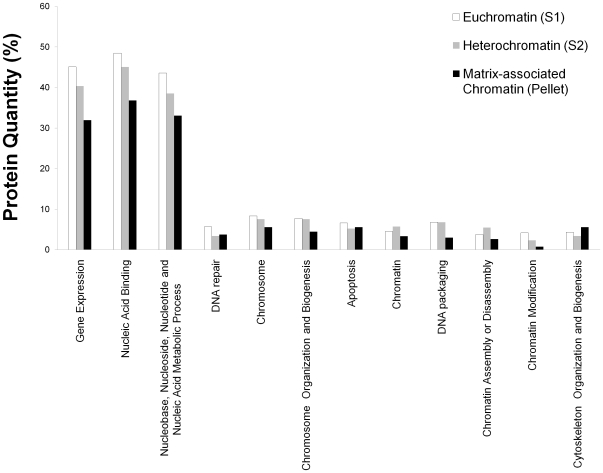
Functional categorization of euchromatin and heterochromatin proteins.The white column corresponds to euchromatin, while the gray and black columns correspond to heterochromatin and matrix-associated chromatin respectively. Protein quantity refers to the percentage of proteins in each category with respect to the total number proteins found in each particular fraction.